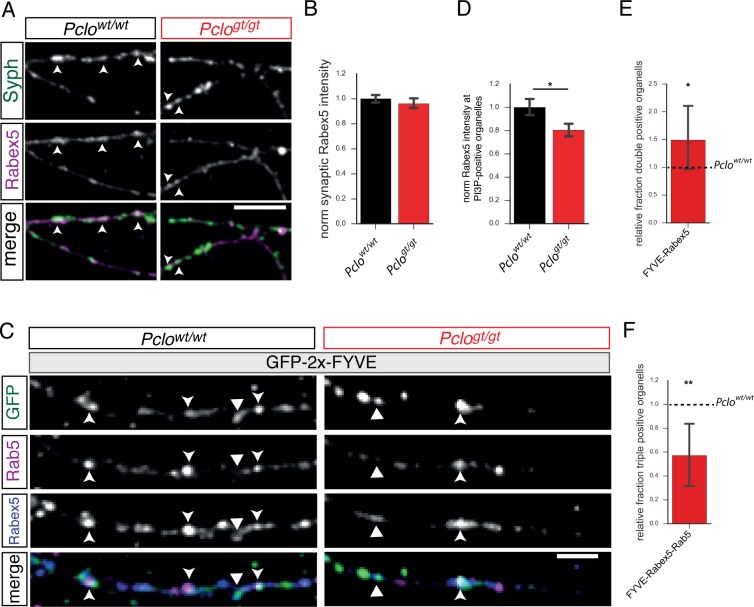
Synaptic Rabex5 levels as well as Rabex5 amounts at PI3P-positive organelles are reduced in neurons lacking Piccolo.(A) Immunocytochemical staining of hippocampal neurons for Rabex5. (B) Quantification of (A). Rabex5 is present at Pclowt/wt and Pclogt/gt synapses, no difference in the intensities is detectable (Pclowt/wt = 1 ± 0.02, n = 2397 synapses; Pclogt/gt = 0.96 ± 0.02, n = 1802 synapses; seven independent experiments). (C) Images depicting Rabex5 intensities at PI3P-positive organelles. (D) Quantification of (C). Less Rabex5 is present at PI3P-positive membranes in Pclogt/gt neurons (Pclowt/wt = 1 ± 0.04, n = 728 puncta; Pclogt/gt = 0.80 ± 0.03, n = 652 puncta; six independent experiments). (E) Quantification of double positive compartments along axons. The fraction of GFP-2x-FYVE/Rabex5 double positive vesicles is increased in Pclogt/gt neurons (Pclogt/gt = 1.49 ± 0.33, n = 5 independent experiments). (F) The relative percentage of GFP-2x-FYVE-Rabex5-Rab5 triple positive compartments is decreased in Pclogt/gt neurons (Pclogt/gt = 0.57 ± 0.14, n = 5 independent experiments). Scale bar represents 10 μm. Error bars in bar graph represent 95% confidence intervals. Numbers given represent mean ± SEM, Student`s t-test.